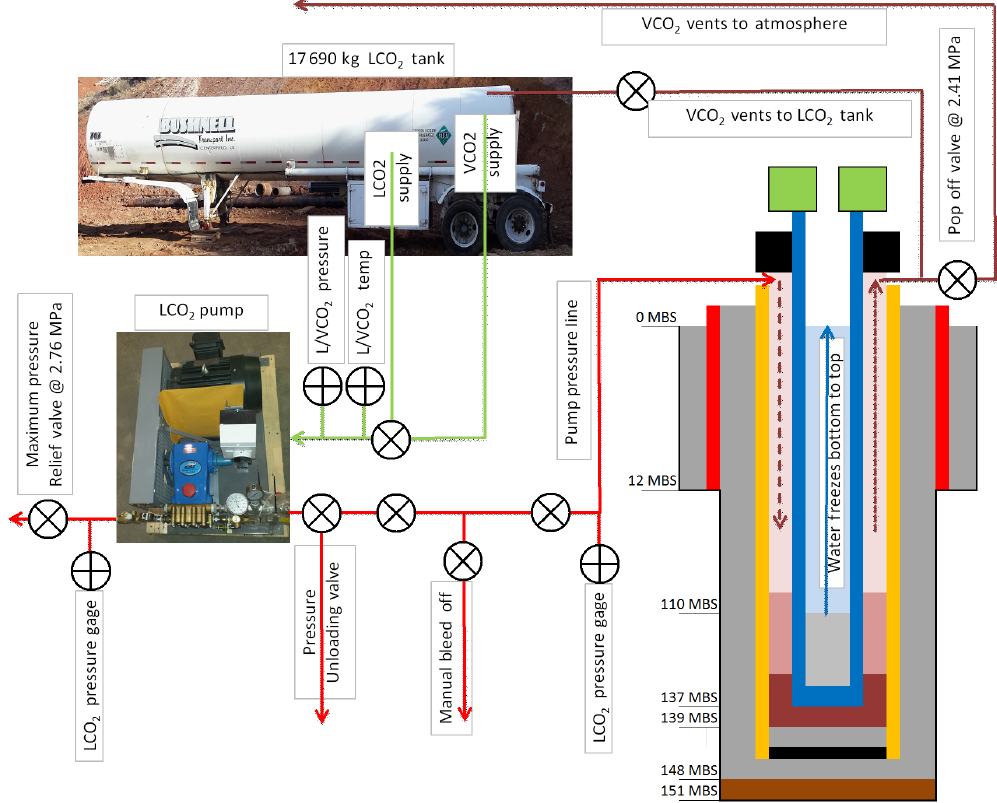
Figure 2. Cooling process diagram for the NAT